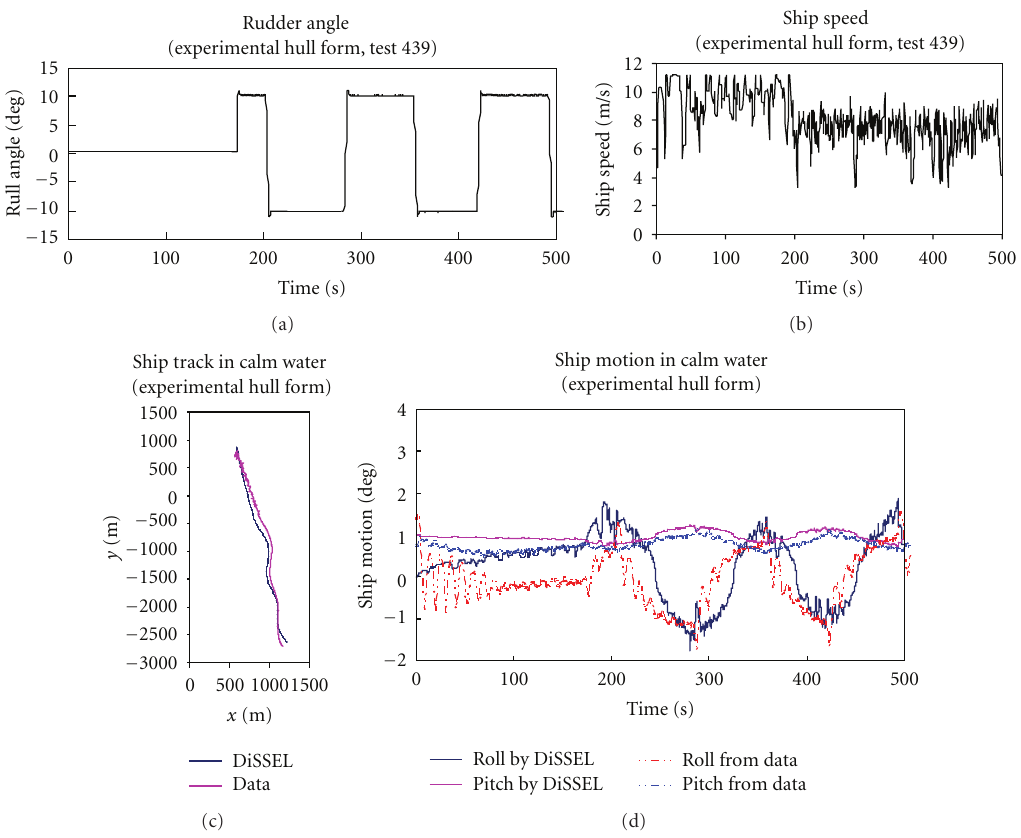
Figure 8: The data input for case 8 are shown in (a) and (b). (a) Rudder angle from data in test 439, (b) ship speed from data in test 439. Benchmark simulations for case 8 are shown in (c) and (d). (c) Comparison of ship track between simulation and experimental data in test 439. (d) Comparison of roll and pitch motion between simulation and experimental data in test 439.